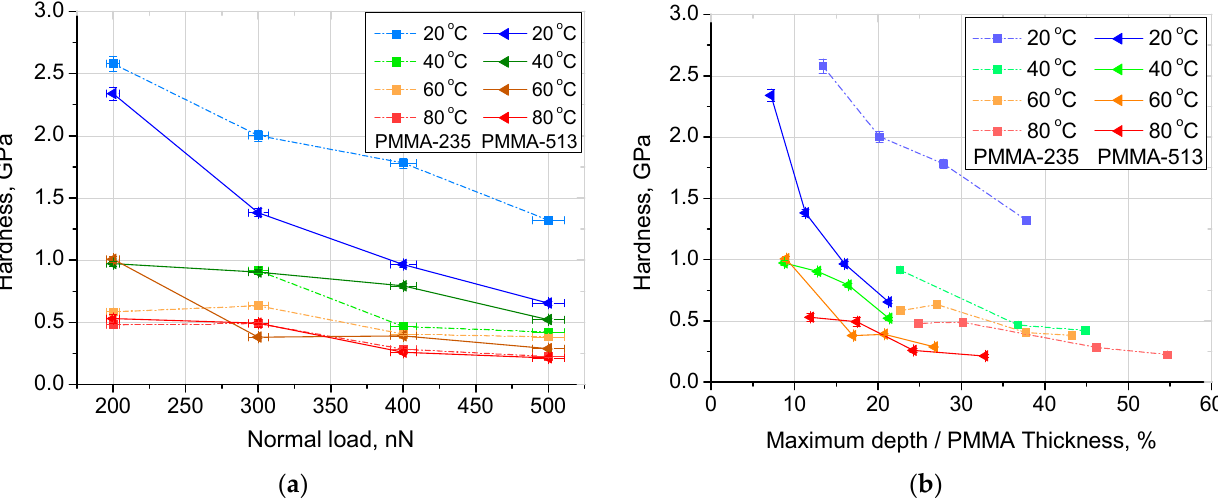
Figure 1. Hardness, obtained by Oliver and Pharr model: ( a ) versus maximum load for PMMA-235 and PMMA-513; ( b ) versus ratio: maximum depth nanoindentation/PMMA thickness, for PMMA-235 and PMMA-513. Lines are just guides for the eyes.